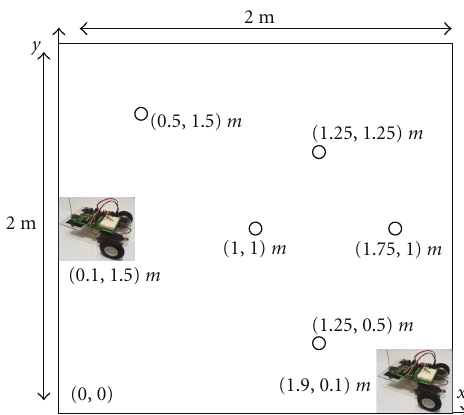
Figure 6: Fixed parameters for the collaborative